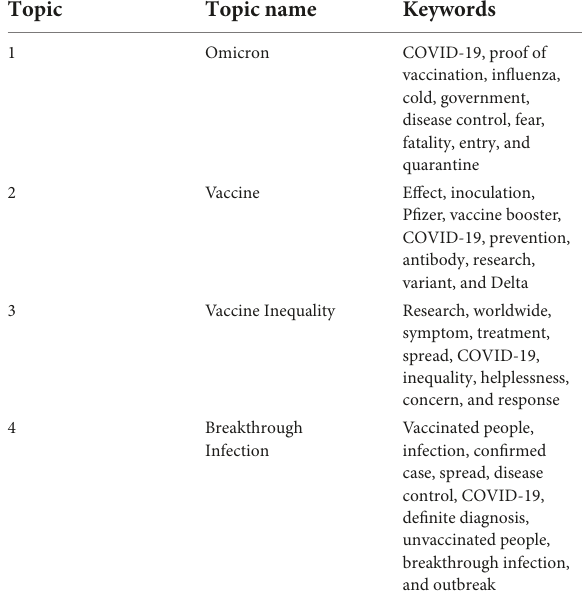
TABLE 2 Results of LDA topic